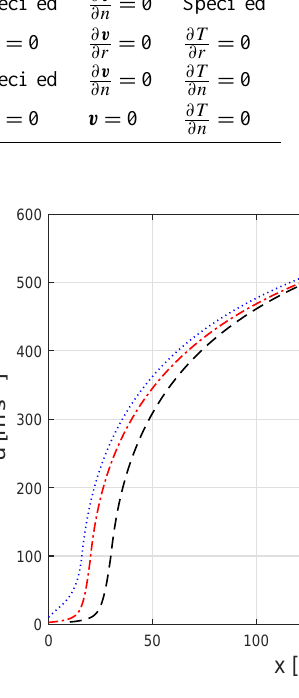
Figure 6. Comparison of titanium particle velocity profiles along the nozzle axis